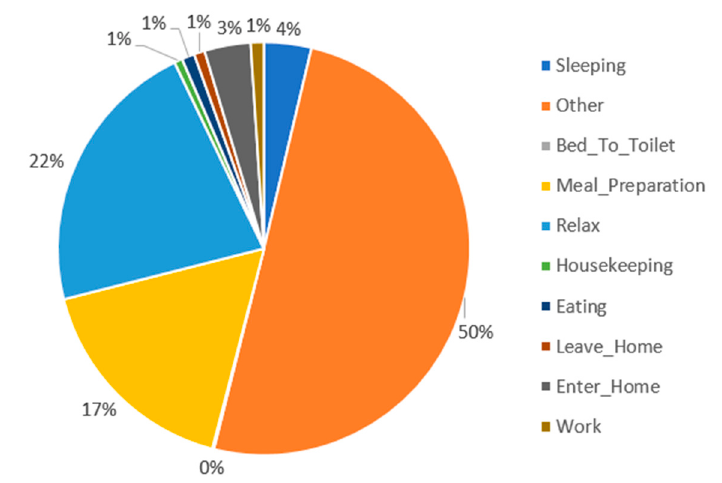
Figure 1. Representative percentile for each of the activities contained within the Aruba Dataset